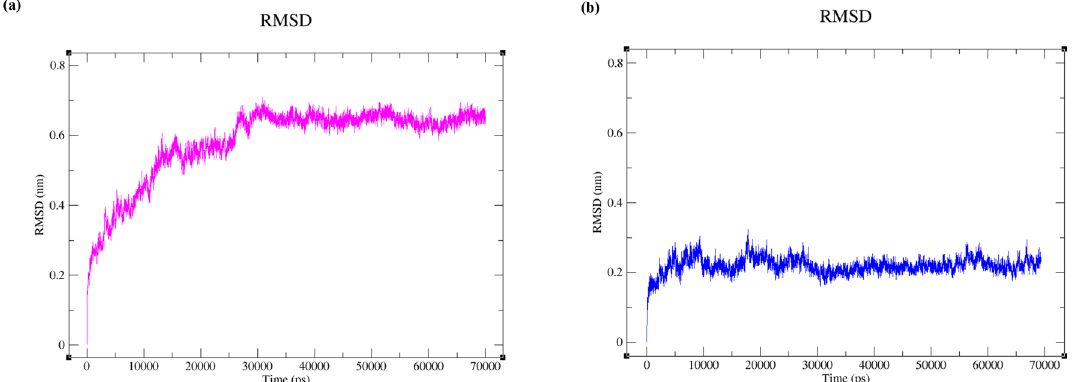
Figure 7. ( a ) Polymerase η backbone RMSD values in the presence of CNP (series 1, pink plot). ( b ) polymerase η backbone RMSD values in the presence of UNK4 (series 2, blue